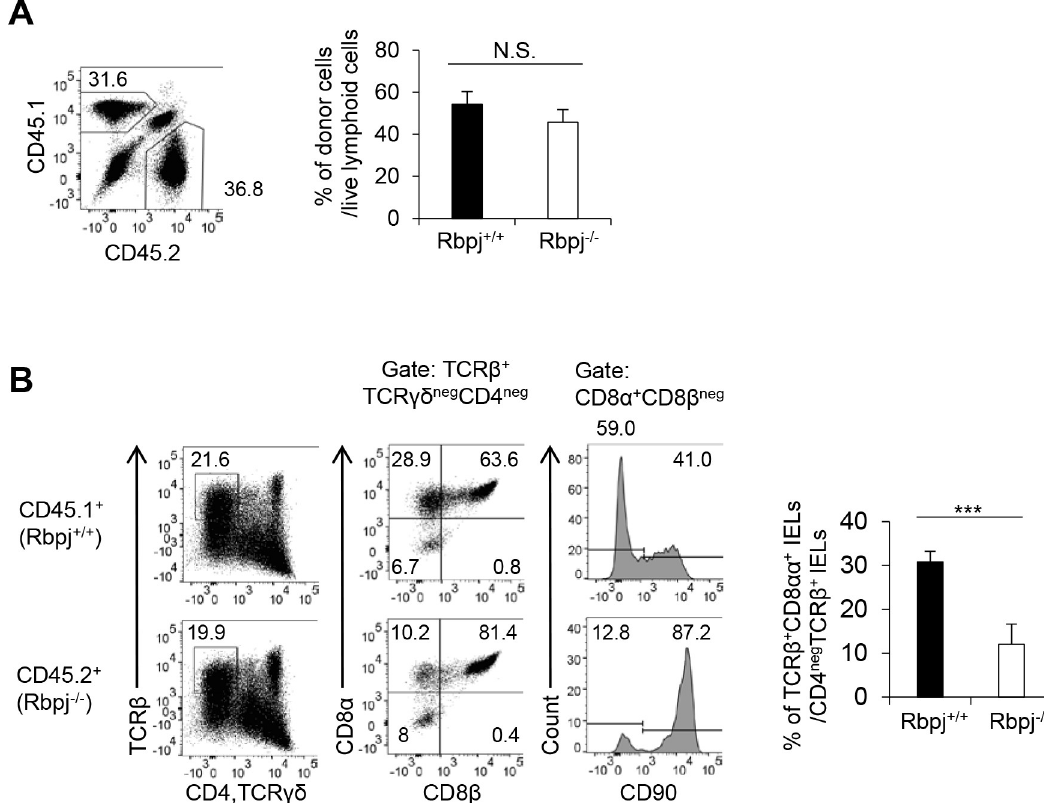
Fig 2. Intrinsic Rbpj in T cells is required for TCR αβ + CD8 αα + IELs. Bone marrow cells (1.5 × 10 7 ) and a 1:1 ratio from Rbpj − / − (CD45.2) and Rbpj +/+ (CD45.1) mice were transplanted into irradiated (9.5 Gy) C57BL/6 mice (CD45.1 + CD45.2 + ). (A) The ratio of intraepithelial CD45 + cells between Rbpj − / − and Rbpj +/+ mice. (B) After 6 wk posttransplantation, the number and frequency of TCR αβ + CD8 αα + IELs from Rbpj − / − (CD45.2) and Rbpj +/+ (CD45.1) mice were evaluated. The data are shown as mean ± S.D., and ��� indicates p < 0.001. The data in (A) and (B) are representative of three independent experiments with n = 5 mice in each experiment. Data associated with this figure can be found in the supplemental data file (S1 Data). IEL, intraepithelial lymphocyte; N. S.; not significant; Rbpj, recombination signal binding protein for immunoglobulin kappa J region; TCR, T-cell